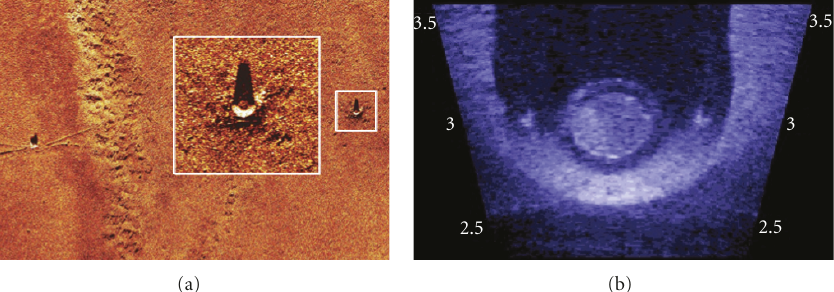
Figure 1: Example of Target in Synthetic Aperture Sonar (a) and Acoustic Camera (b). Images are courtesy of the NATO Undersea Research Centre (a) and Soundmetrics Ltd (b).